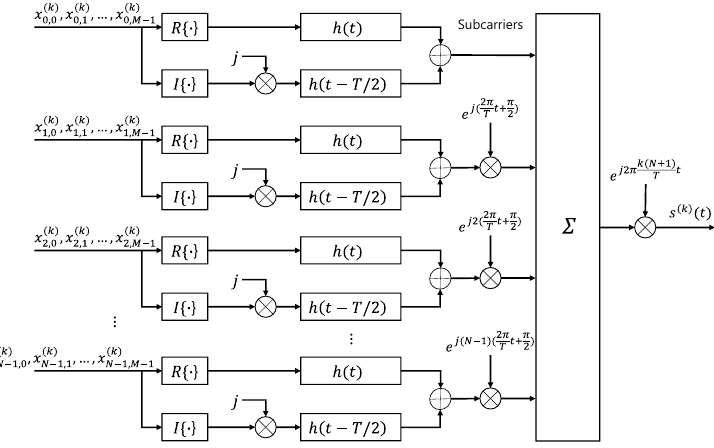
Figure 2. Structure of the k -th user’s filter bank multicarrier (FBMC) transmitter.